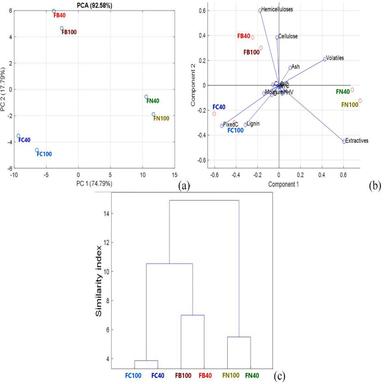
PCA plot (a), the biplot (b) and the hierarchical clustering (c) of the fir bark, needles and cones according to proximate/ultimate analysis and chemical composition.